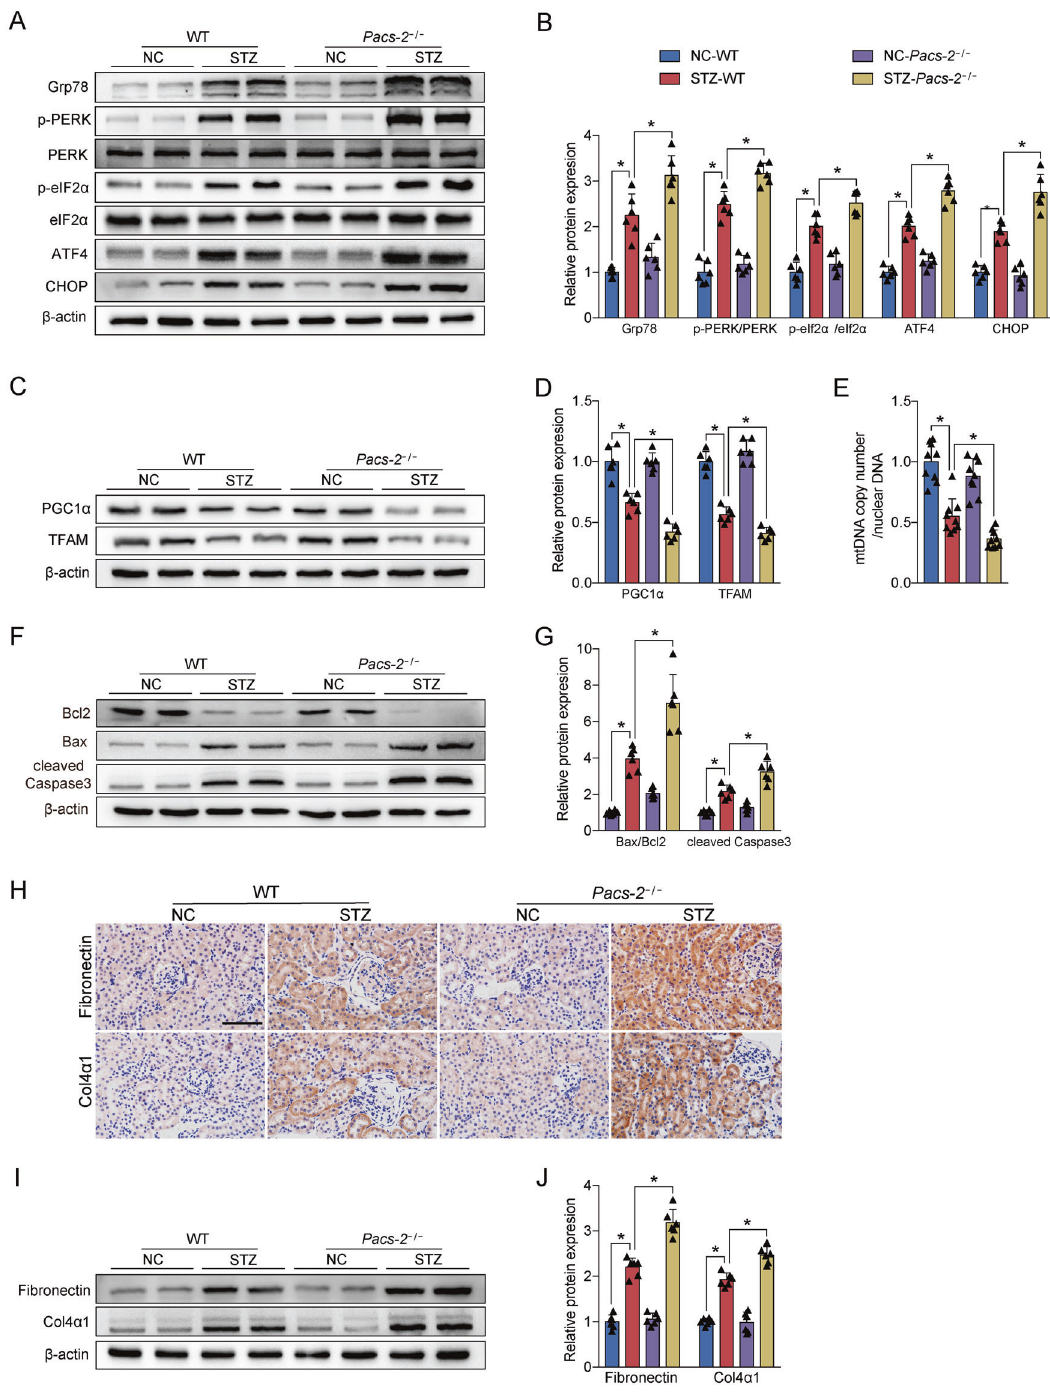
Fig. 3 Diabetes-associated ER stress, mitochondrial dysfunction, apoptosis, and fi brosis were exacerbated in PACS-2 knockout kidneys. A Western blot bands of Grp78, p-PERK, PERK, p-eIF2 α , eIF2 α , ATF4, and CHOP in kidney lysates. B Quantitative analysis of indicated protein levels in A . n = 6. C Western blot bands of TFAM and PGC1 α in kidney lysates. D Quantitative analysis of indicated protein levels in C . n = 6. E Measurement of mtDNA copy number normalized to the nuclear gene. n = 9. F Western blot bands of Bax, Bcl2, and cleaved Caspase3 in kidney lysates. G Quantitative analysis of indicated protein levels in F . n = 6. H Immunohistochemical staining of Fibronectin and Col4 α 1 in the kidney sections. Scale bar = 100 μ m. I Western blot bands of Fibronectin and Col4 α 1 in kidney lysates. J Quantitative analysis of indicated protein levels in ( I ). n = 6. All data are expressed as mean ± SD. * P <